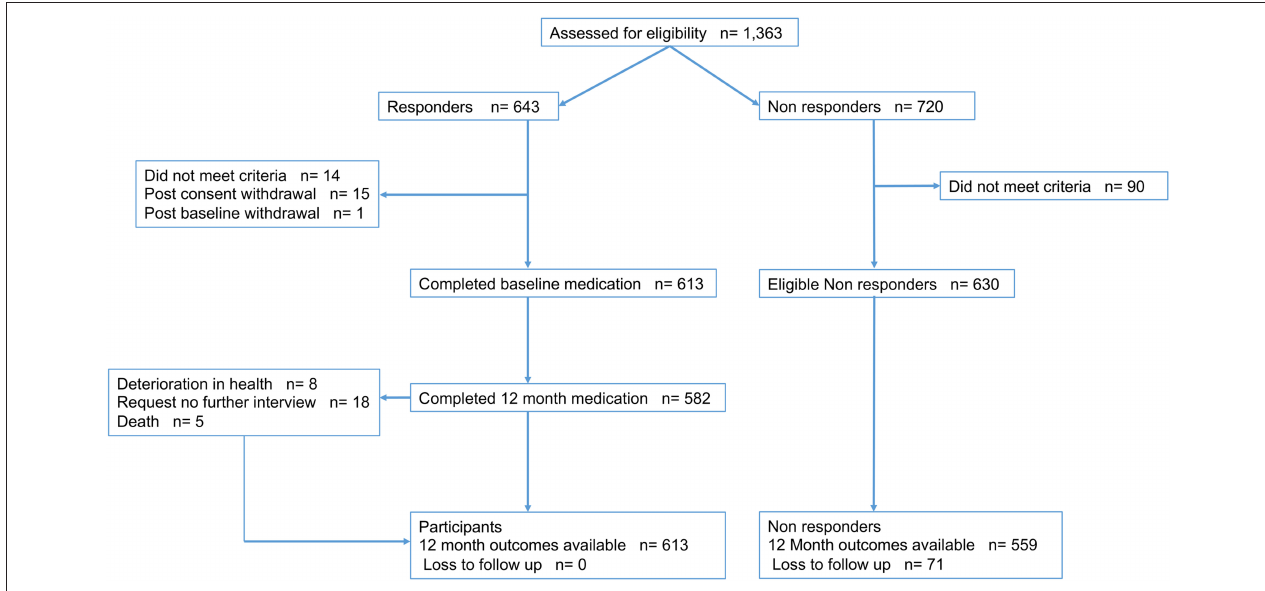
FIGURE 1 | INSIST study